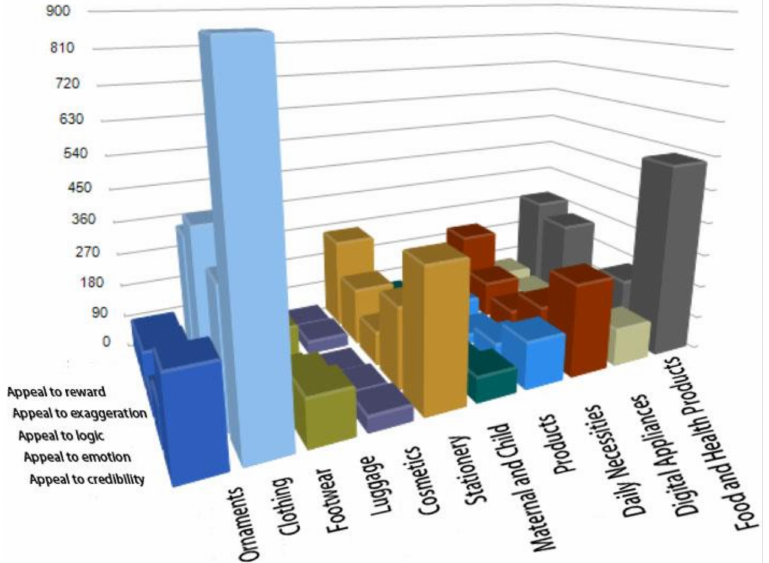
Figure 4. The number of times the linguistic style is used for various types of